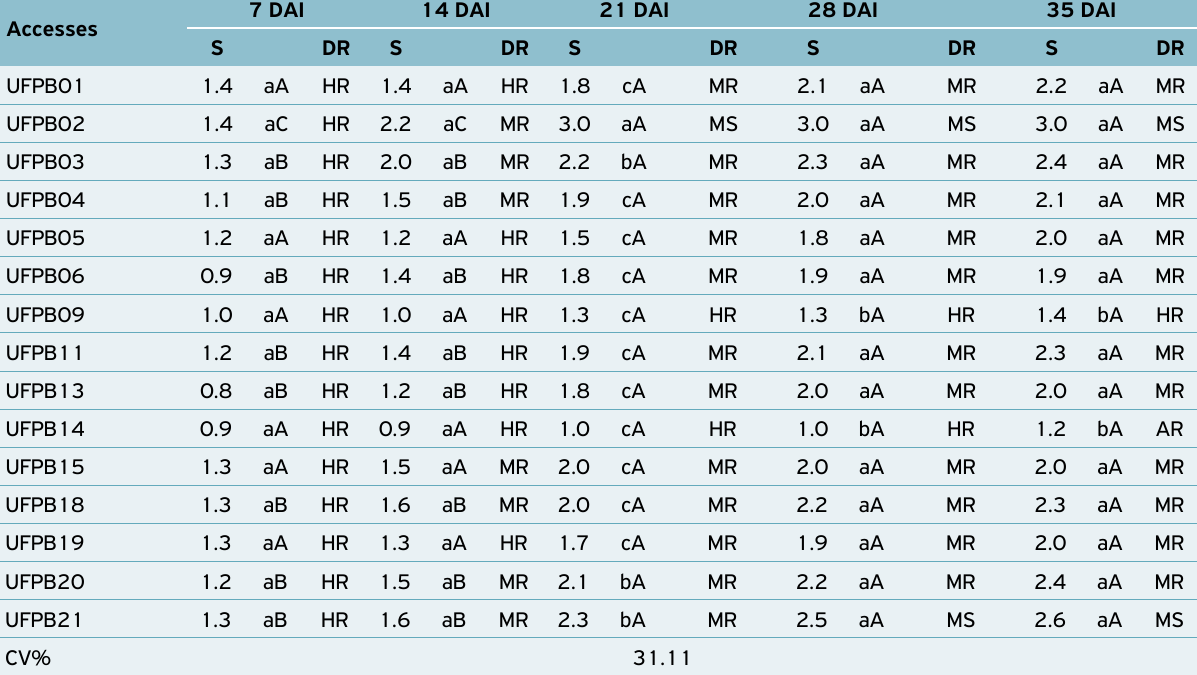
Table 2. Severity and anthracnose degree of resistance between accesses lima bean ( Phaseolus lunatus L.) days after